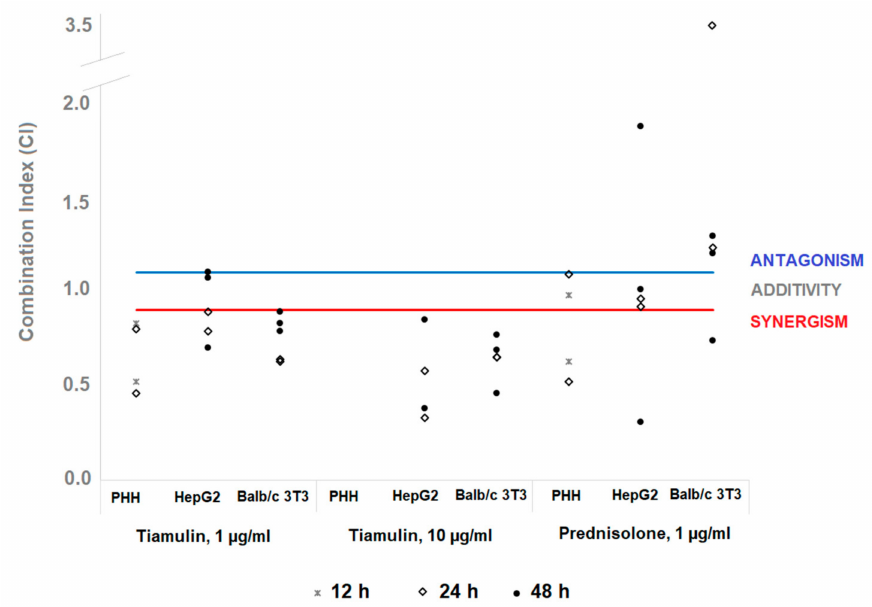
Figure 1. The combination index (CI) used for the denomination of the mode of interaction between salinomycin and tiamulin or prednisolone. The cut-o ff values for synergism and antagonism (0.9 and 1.1, respectively) are shown for comparison. CI was assessed for three cell models in three exposure times, each during three independent biological experiments. Every dot represents a value calculated with a specific endpoint (MTT, NRU, TPC, and LDH assay). The calculation of CI was not possible for all combinations of the model, exposure time, and